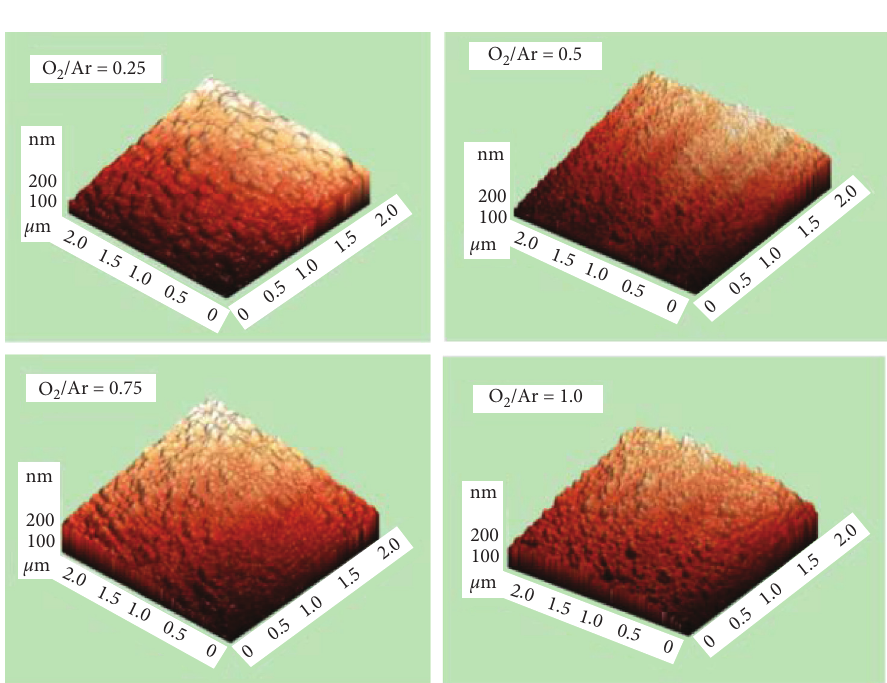
Figure 3: Image topology of film prepared at various ratios of oxygen/argon.